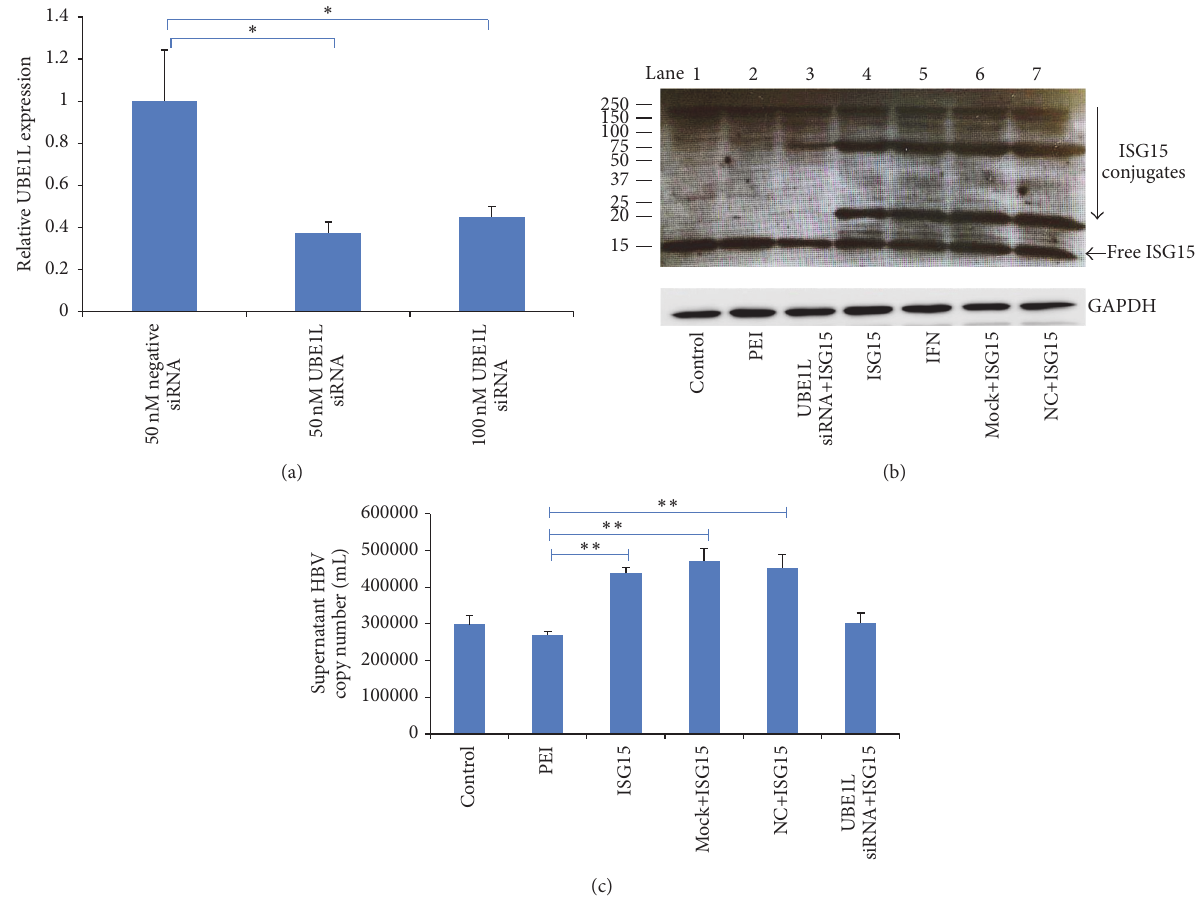
Figure 4: ISGylation is important in ISG15-promoted HBV production . UBE1L knockdown was performed by RNAi to abrogate ISGylation in HepG2.2.15 cells. (a) Knockdown efficiency was determined by real-time PCR showing UBE1L mRNA expression 24 h after 50 nM negative siRNA, 50 nM UBE1L siRNA, or 100nM UBE1L siRNA treatment. (b) Comparison of protein ISGylation (western blot for ISG15) after UBE1L knockdown and ISG15 overexpression. Molecular mass markers are shown on the left (kDa). (c) Real-time PCR was used to assess the supernatant HBV DNA after UBE1L knockdown and ISG15 overexpression. Control, untreated control; PEI, ISG15 transfection regent polyethyleneimine (PEI) treatment only; ISG15, ISG15 overexpression by transfection with 1.4 𝜇 g ISG15 plasmid; UBE1L siRNA+ISG15, 50 nM UBE1L siRNA treatment followed by ISG15 overexpression; Mock+ISG15, siRNA transfection regent treatment followed by ISG15 overexpression; NC+ISG15, 50 nM negative siRNA treatment followed by ISG15 overexpression; IFN, 100IU/mL IFN 𝛼 2b treatment. The results are presented as the means ± SD, 𝑛 ≥ 3 ; error bars indicate SD. ∗ 𝑃 < 0.05; ∗∗ 𝑃 < 0.01